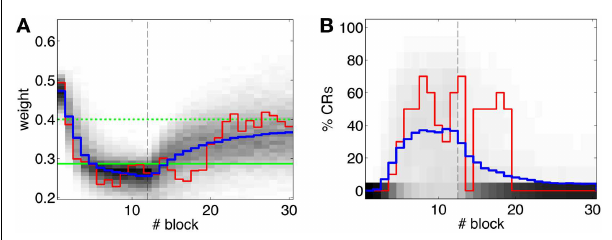
FIGURE 10 | Performance of the experiment predicted by the training data. (A) Trajectory of the memory parameter after 2500 simulations plotted in blocks of 10 trials.The simulated experiment contained 120 trials of acquisition and 180 trials of extinction. Distribution of the block-by-block values of w (grayscale) with mean (blue) and output of a sample simulation (red) are shown.We indicate the levels of the weight that result in late (upper green line) and well-timed CRs (lower green line).The transition from acquisition to extinction training is marked by a vertical line. (B) Predicted behavioral performance after 2500 simulations. Percentage of well-timed CRs. Distribution of the block-by-block performance (grayscale) with mean (blue) and result (red) of a sample simulation [same as in (A) ]. FIGURE 11 | Event detections and triggers during the online